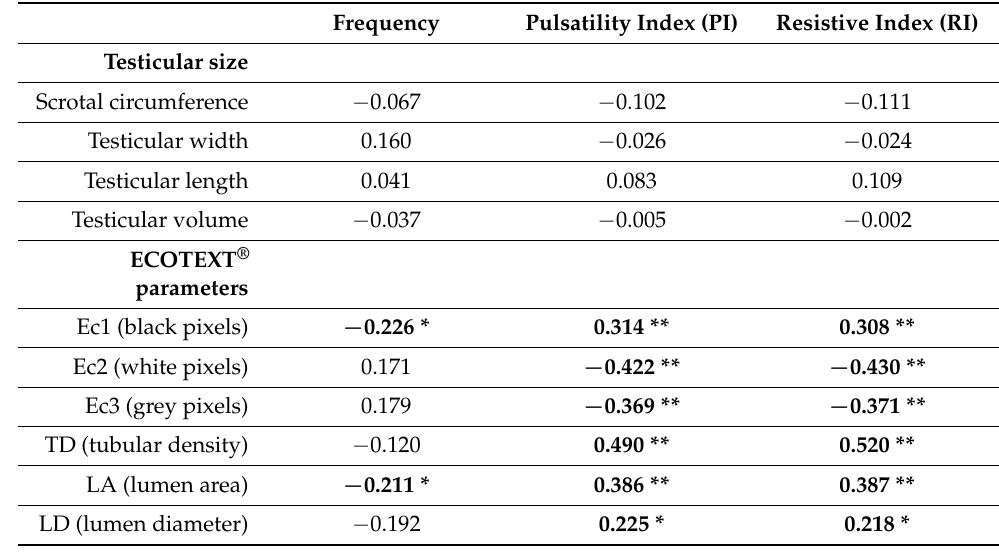
Table 7. Spearman’s rank correlation coefficient (Spearman’s ρ ) between testicular size or echotexture parameters (evaluated by ultrasound-video analysis and ECOTEXT ® software) and testicular-artery blood flow (assessed by color-Doppler flow imaging) in Rasa Aragonesa rams ( n = 96). Bold type indicates statistically significant correlations. * p < 0.05 and ** p <